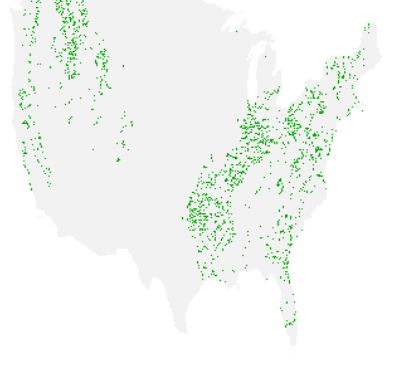
Figure 9. Precipitation pattern change of deformation in anti-clockwise